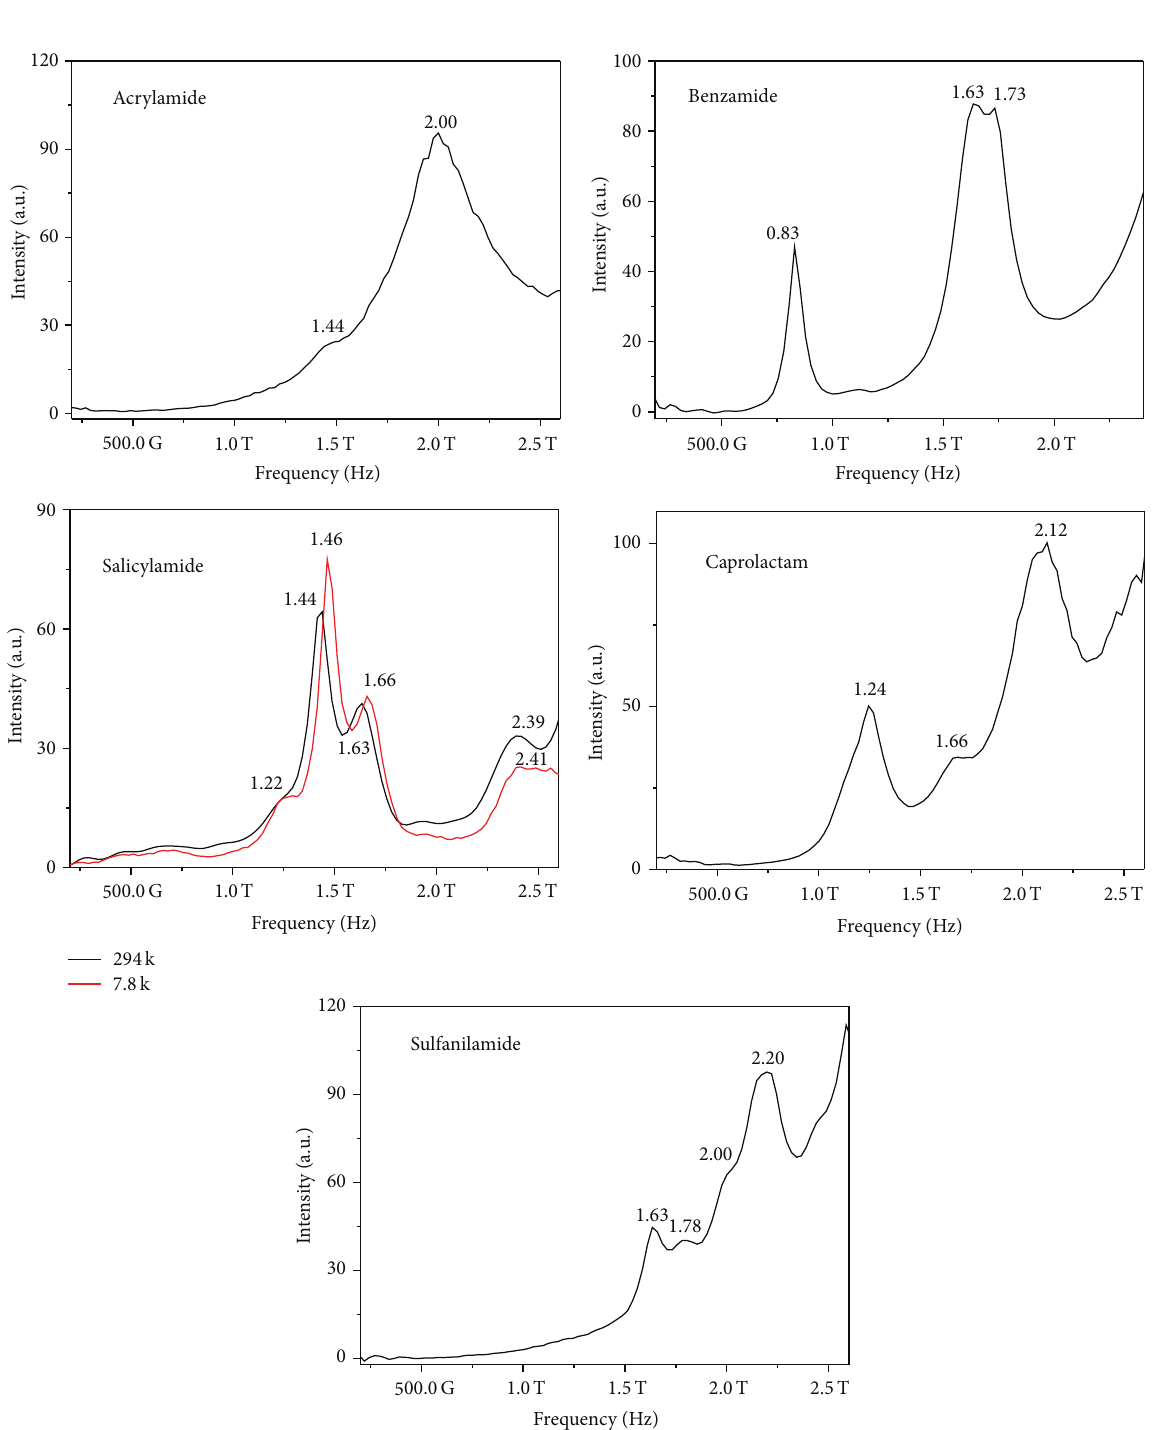
Figure 2: THz absorption spectra of acrylamide, benzamide, salicylamide, caprolactam, and